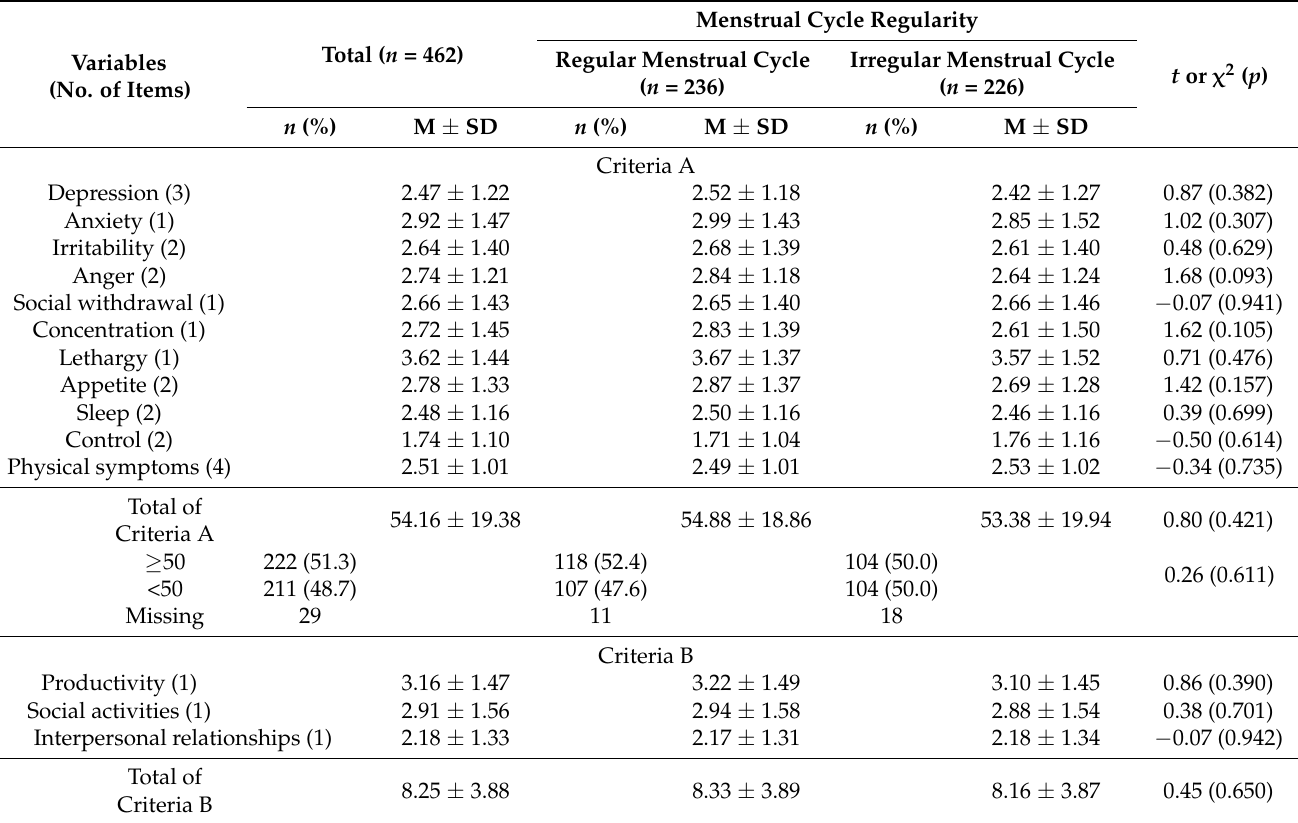
Table 4. Premenstrual symptoms according to menstrual cycle regularity ( n =